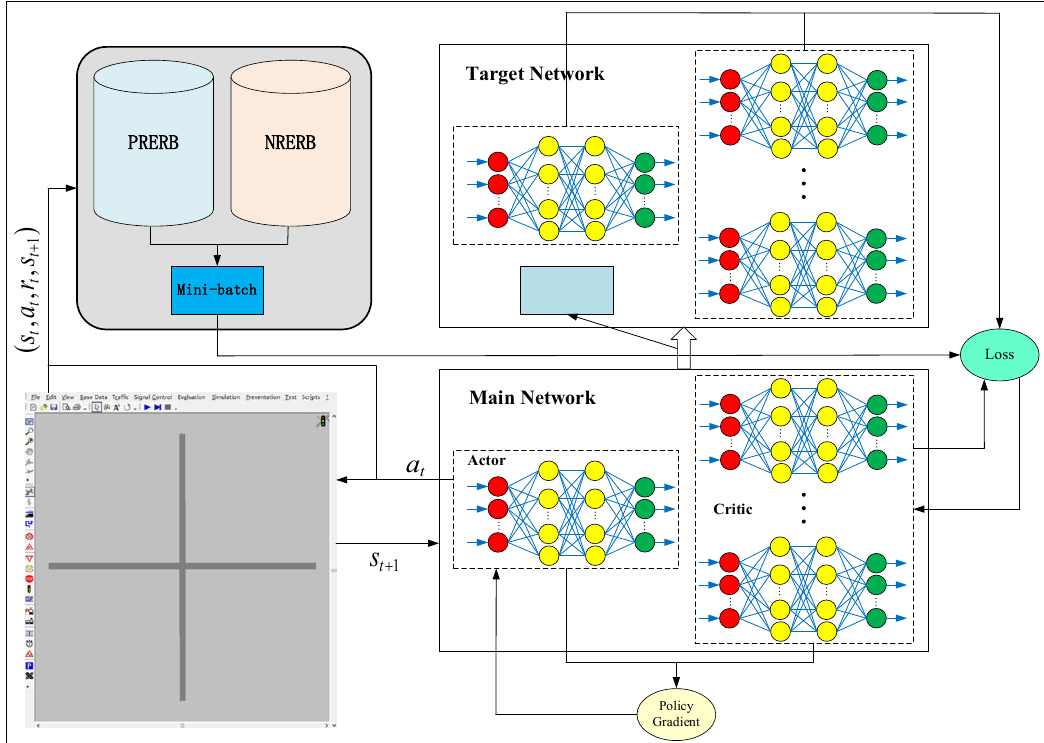
Figure 2. Interaction between the PNRERB-MC-DDPG method and VISSIM software. Algorithm 1 PNRERB-MC-DDPG method